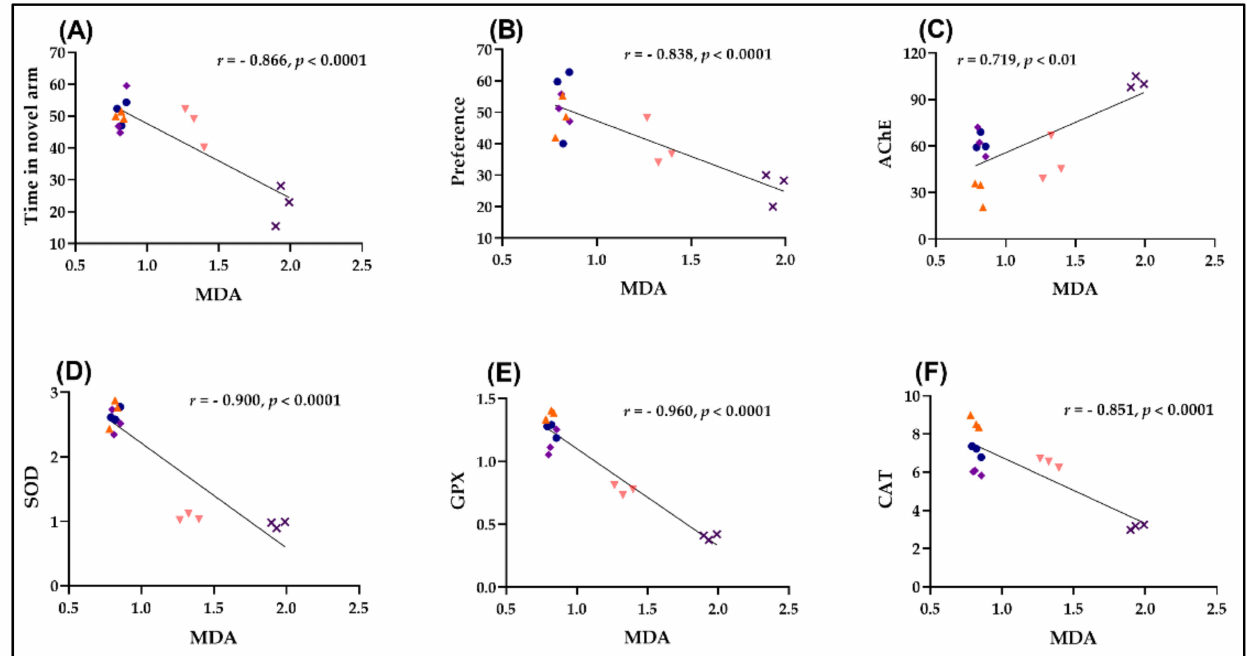
Figure 5. Correlation analyses between behavioral and biochemical parameters (Pearson’s correla- tion). Data expressed are time in the novel arm (s), preference (%), AChE (nmol/min/mg